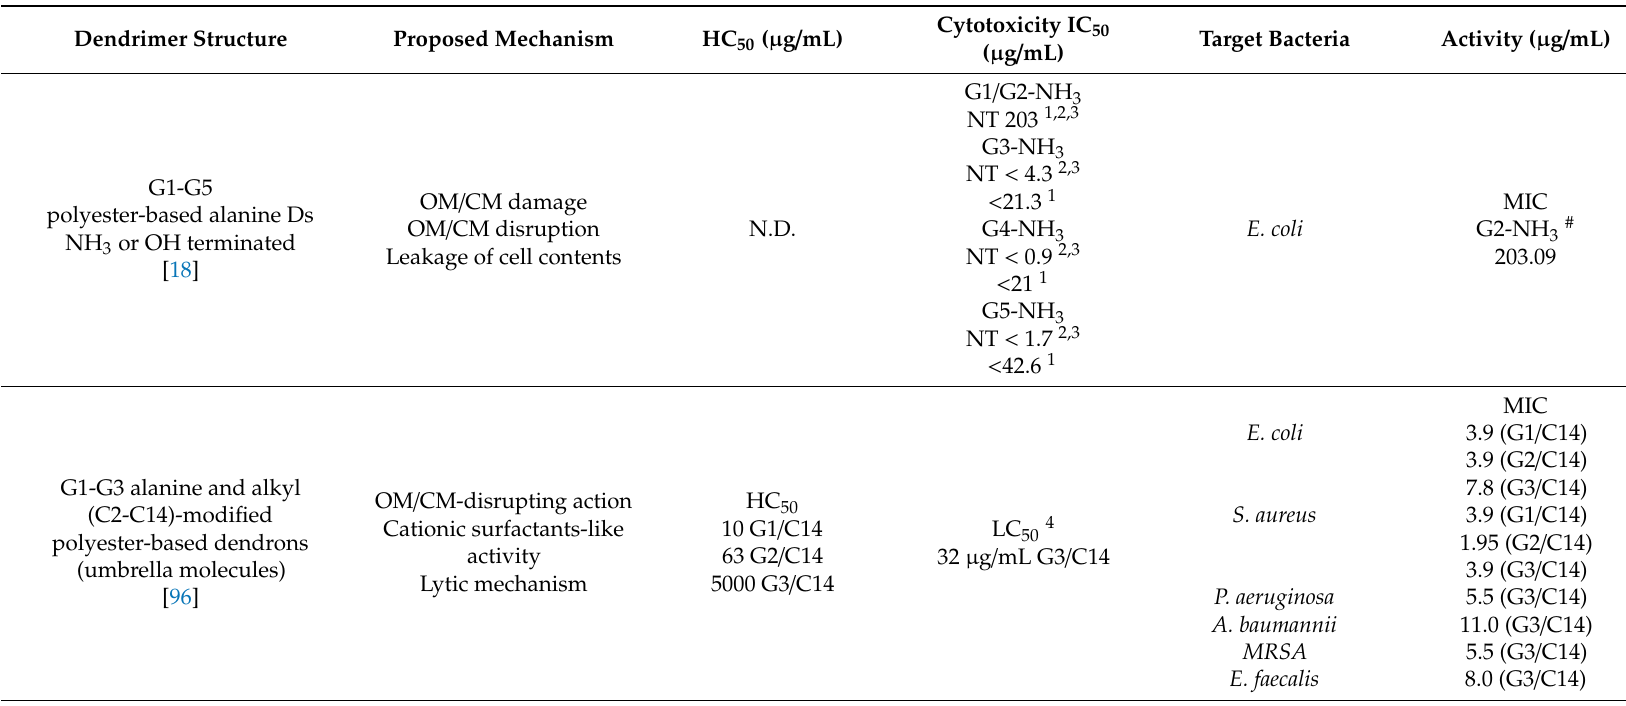
Table 8. Entirely polyester-based amino acid-modified cationic Ds developed recently and antibacterial activity of the most e ff ective ones among the synthetized